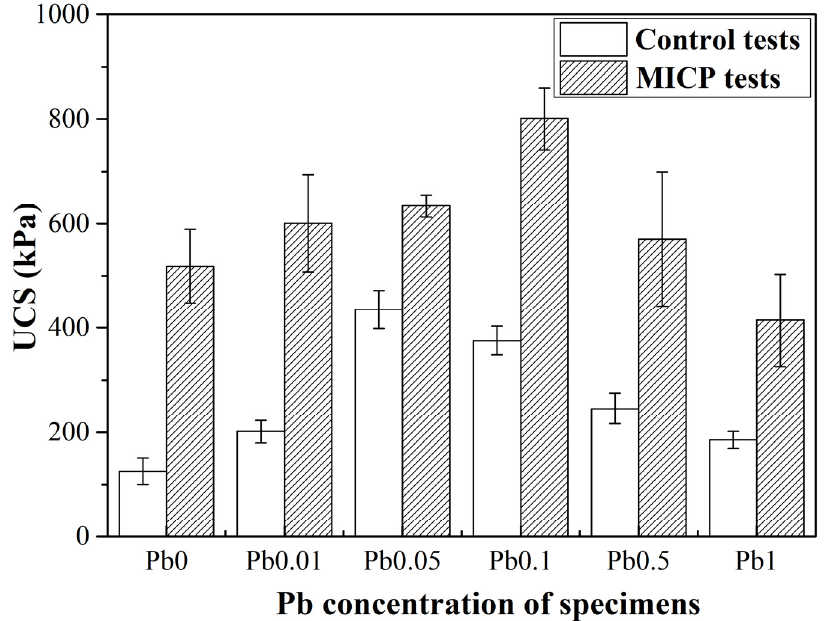
Figure 8. Unconfined compression strengths (UCS) of silty soil samples with different initial Pb concentrations, cured using the MICP process.